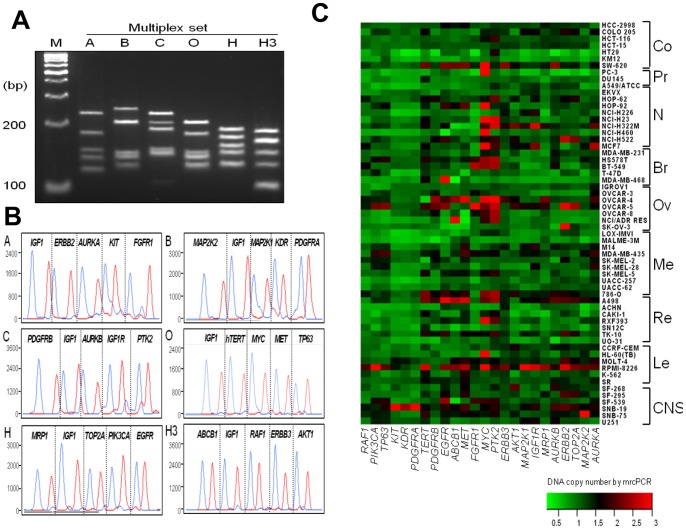
Measurements of copy numbers for 24 drug-target genes by mrcPCR in NCI-60 cells.(A) PCR amplification products from each of six multiplex PCR (A, B, C, O, H, and H3) separated by 5% NuSieve® agarose gel electrophoresis. (B) Representative peaks from analysis of products of six single-base-extension reactions (A, B, C, O, H, and H3) in a control whole-blood DNA sample. Five peak pairs are shown for four target genes and one reference gene in each reaction. Each pair of peaks is from either genomic DNA (blue) or the competitor (red). (C) Heatmap of copy numbers for 24 genes in NCI-60 cells. Each copy number was measured three times and the mean values were used. Co, colon; Pr, prostate; N, NSCLC; Br, breast; Ov, ovarian; Me, melanoma; Re, renal; Le, leukemia.